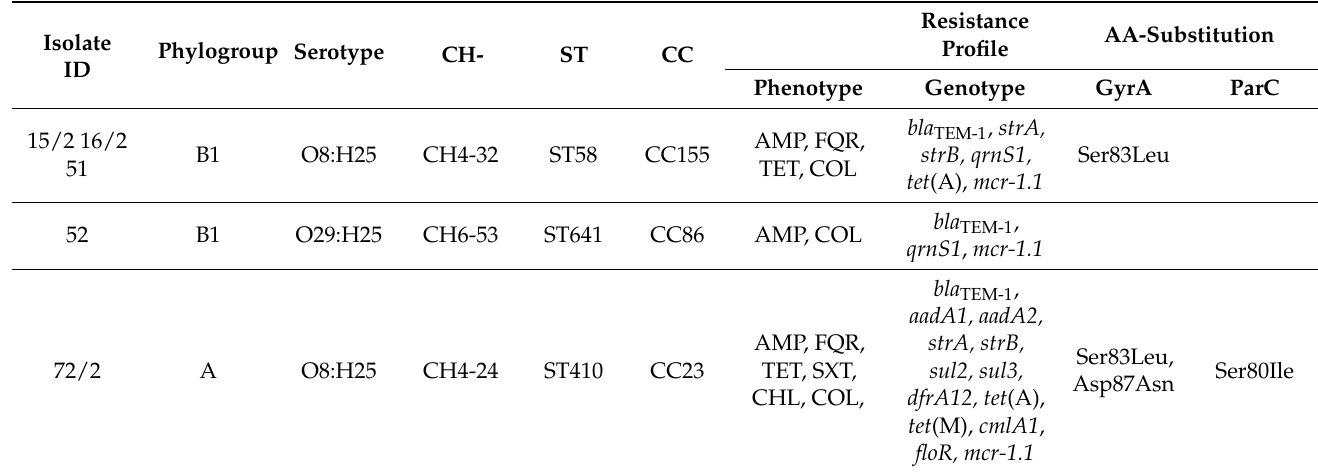
Table 1. Results of the molecular characterization and resistance profile of mcr-1 carrying E. coli